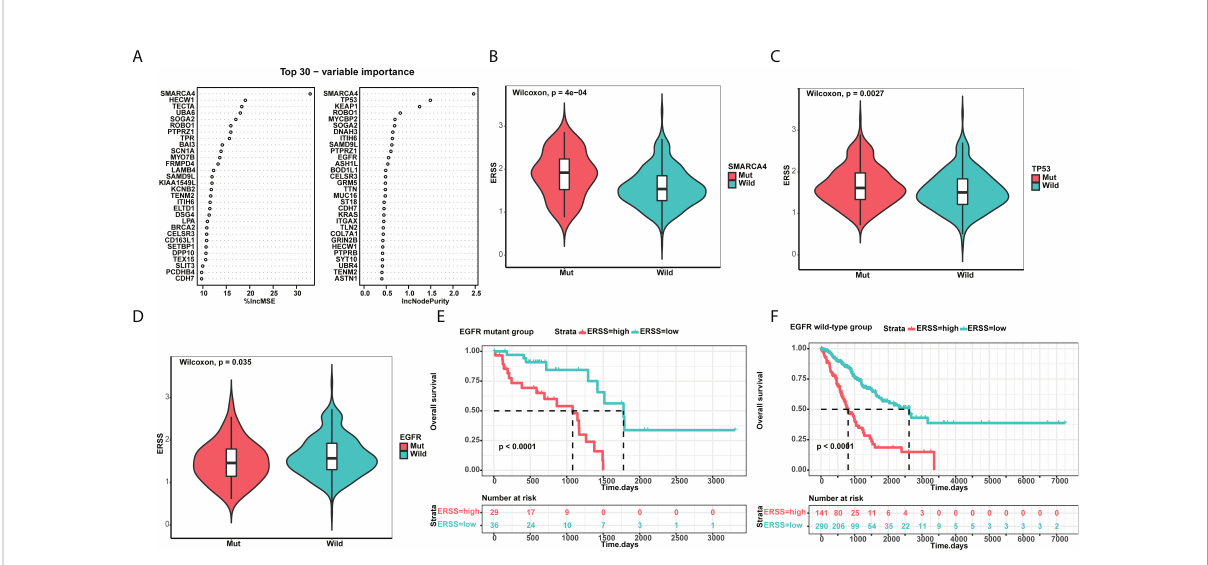
FIGURE 6 ERSS correlated with driver gene mutations. (A) Random forest selected the top 30 important mutant genes that associated with ERSS. (B, C) Patients with SMARCA4 and TP53 mutations showed signi fi cantly higher ERSS ( p = 4e − 04 and 0.0027, respectively). (D) Patients with EGFR mutation showed lower ERSS ( p = 0.035). (E, F) Patients with high ERSS had signi fi cantly longer OS neither in EGFR mutant nor in wild-type group (both p < 0.0001). ERSS, endoplasmic reticulum stress score; TCGA, The Cancer Genome Atlas; OS, overall